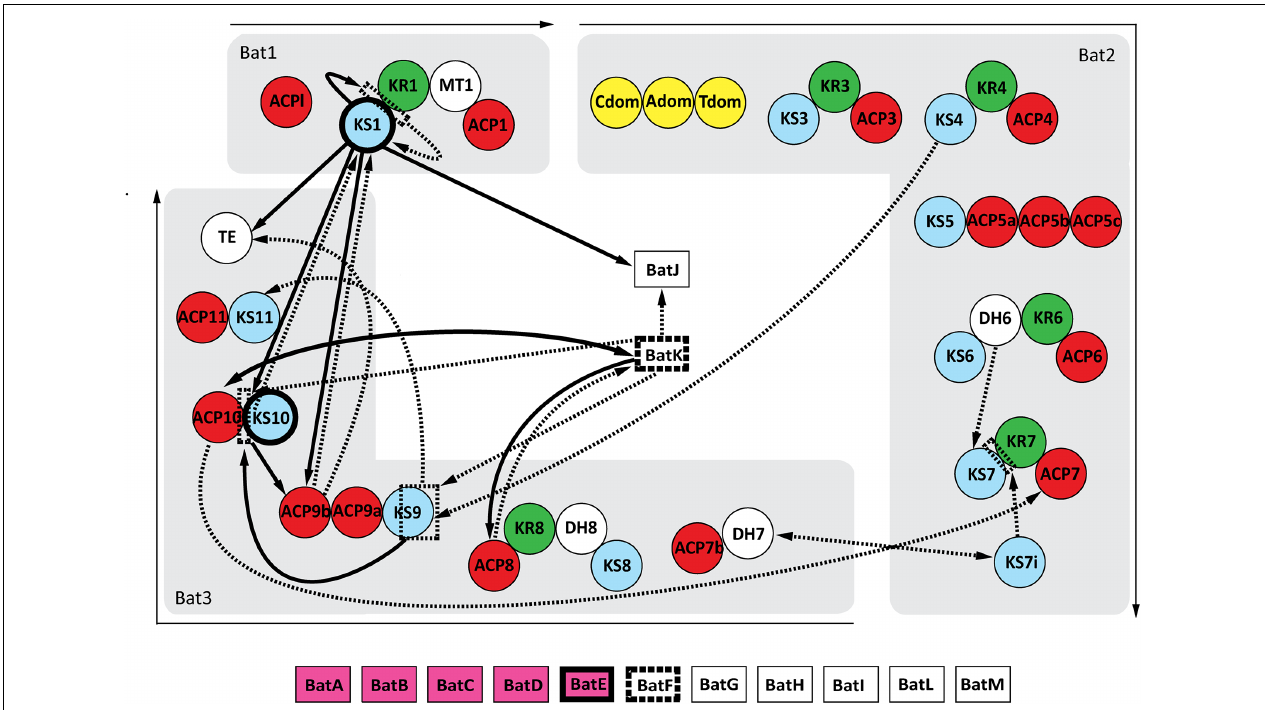
FIGURE 2 | Interaction map of the kalimantacin assembly line. Arrows demonstrate the identified protein interactions during Y2H analysis. Single arrows connect the bait protein with its interacting prey partner, whereas double heads indicate interactions found in both the original as reciprocal screen. If the arrow lines are dashed, they represent interactions only found during the initial Y2H screening, whereas protein-proteins interactions shown in full black lines were confirmed during further testing. Domains with a highlighted frame indicate the formation of